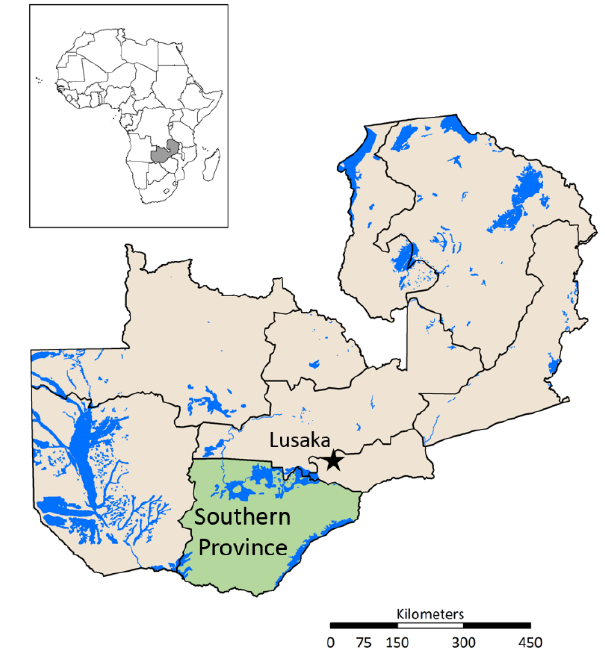
Figure 1. Country of Zambia with provinces outlined in black and water bodies/seasonally inundated areas in blue. The Southern Province is highlighted in